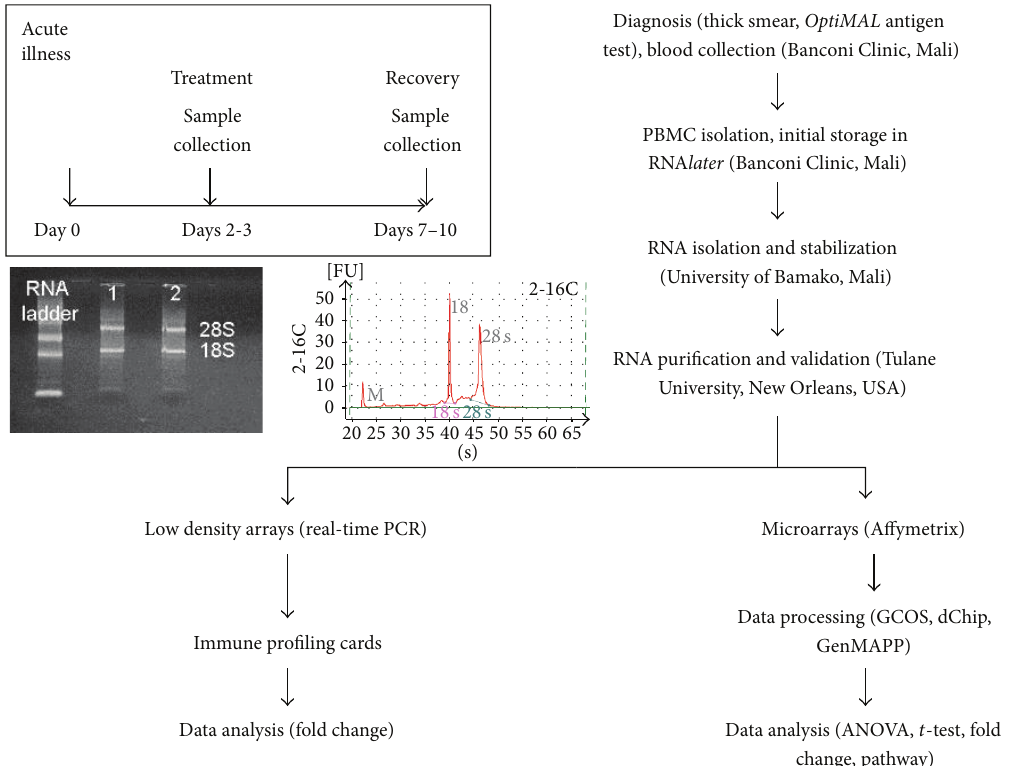
Figure 1: Study design and flow chart for sample collection. The time line (upper left) provides the times when the 3 samples were collected. The insets provide sample results of the procedures used to test RNA quality: agarose gel electrophoresis performed on-site in Mali (left) and capillary electrophoresis using the Agilent Biolanalyzer 2100 in New Orleans (right). Flow chart for sample collection, quality control, and studies